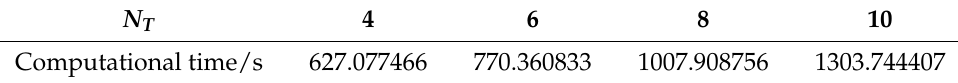
Figure 2. Worst-case SINR values of the waveform and filter with the proposed design versus the iteration number. Table 1. Computational times of the proposed algorithm with different transmitting array